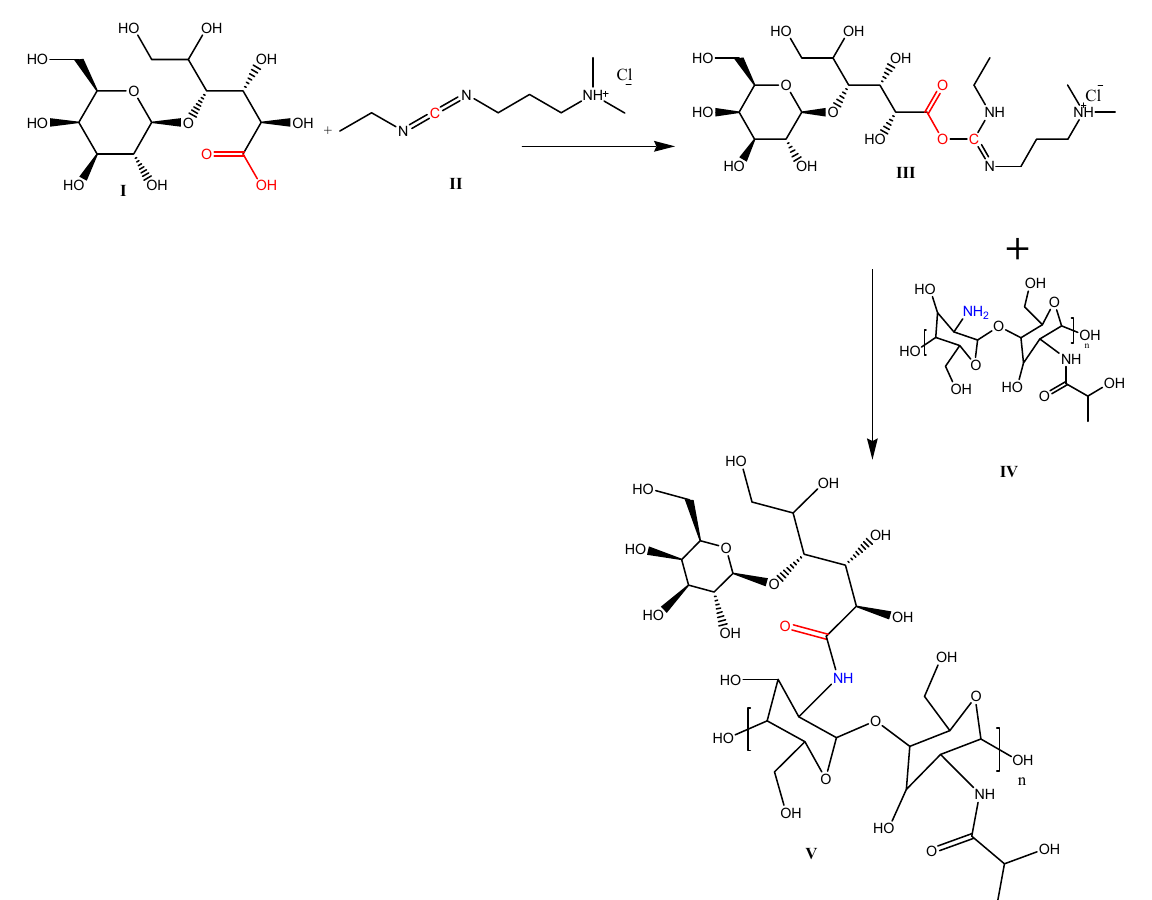
Table 3. Effect of sonication on EE%, PS, and ZP of LA-free NPs and LA-modified NPs.